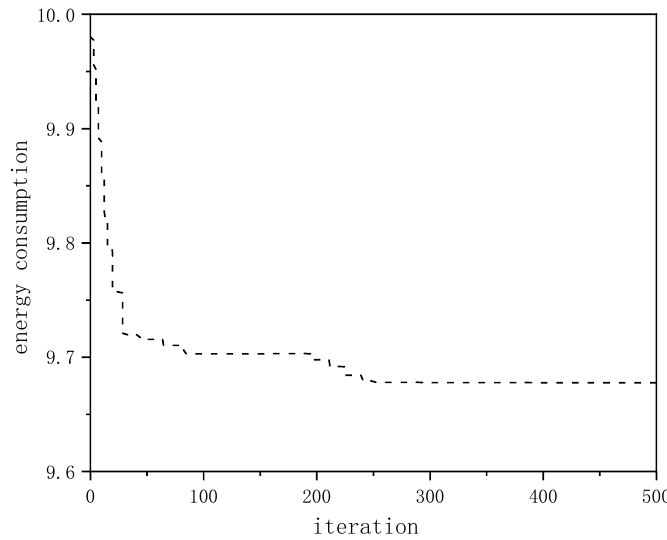
Figure 9. Energy consumption convergence algebraic diagram.